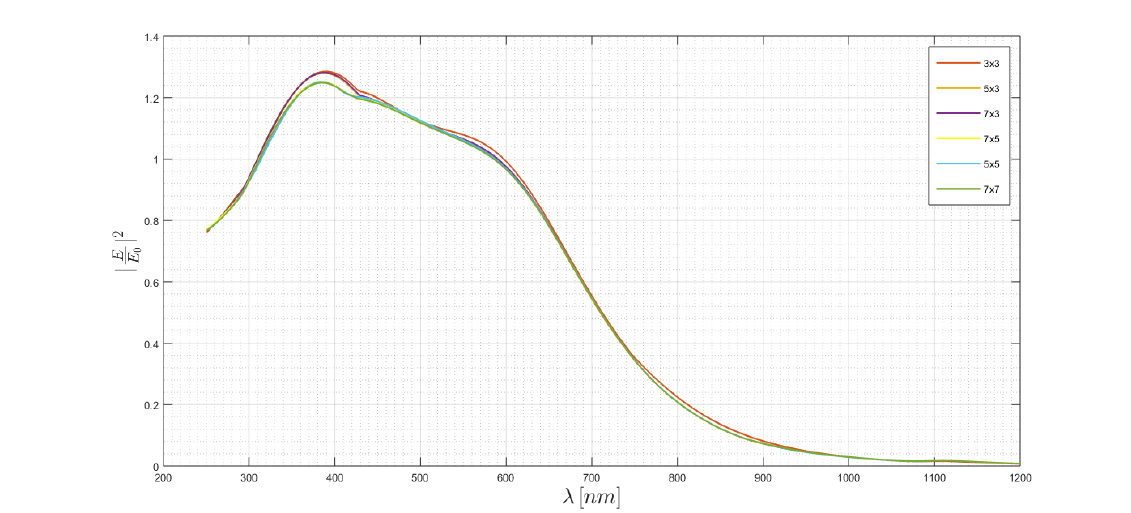
Figure 18. Sweep of the number of holes that composed the aluminum